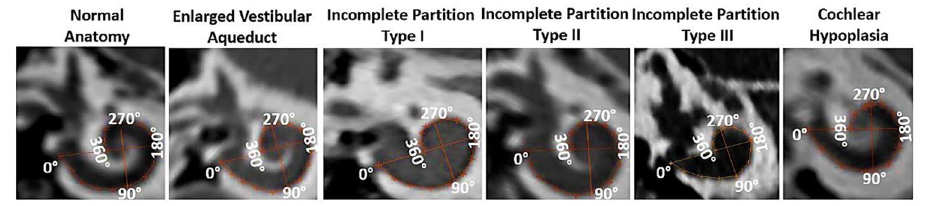
Figure 2. Oblique coronal views showing the cochlear basal turn of various inner ear anatomical types displaying the A- (long axis line), B- (short axis line) value, and basal turn length (BTL) manually tracked (360° coverage).